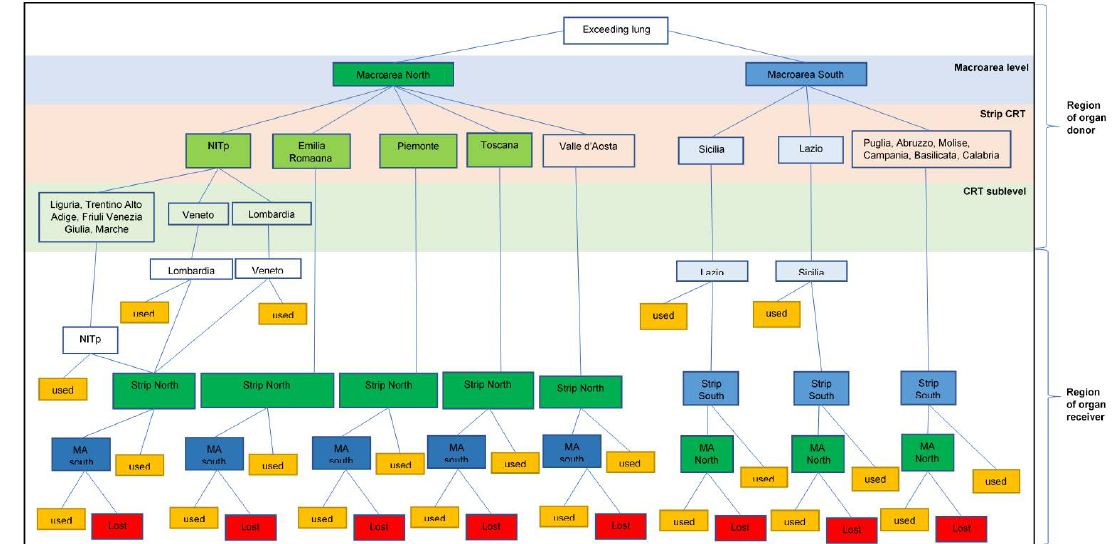
Figure 1. Flowchart of the allocation of exceeding lungs according to the national surplus protocol. The upper part refers to what happens in the donor region and the lower part shows what happens in the recipient’s location. In the upper part, there are two macroareas (north and south), which include a CRT on a regional basis and a grouping of several NITp regions. The CRTs highlighted in green and blue are those in which CRTs are present for the lung transplants and the regions without CRTs for lung transplants are grouped in boxes without any color.